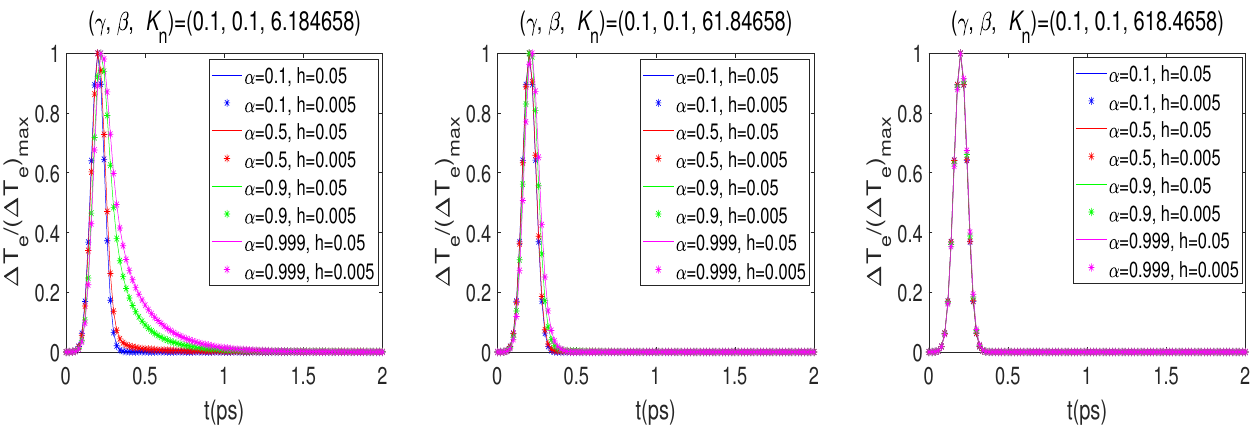
Figure 9. Changes in electron temperature ∆ T e / ( ∆ T e ) max and various K n , α , and ( γ , β ) = ( 0.1,0.1 ) .